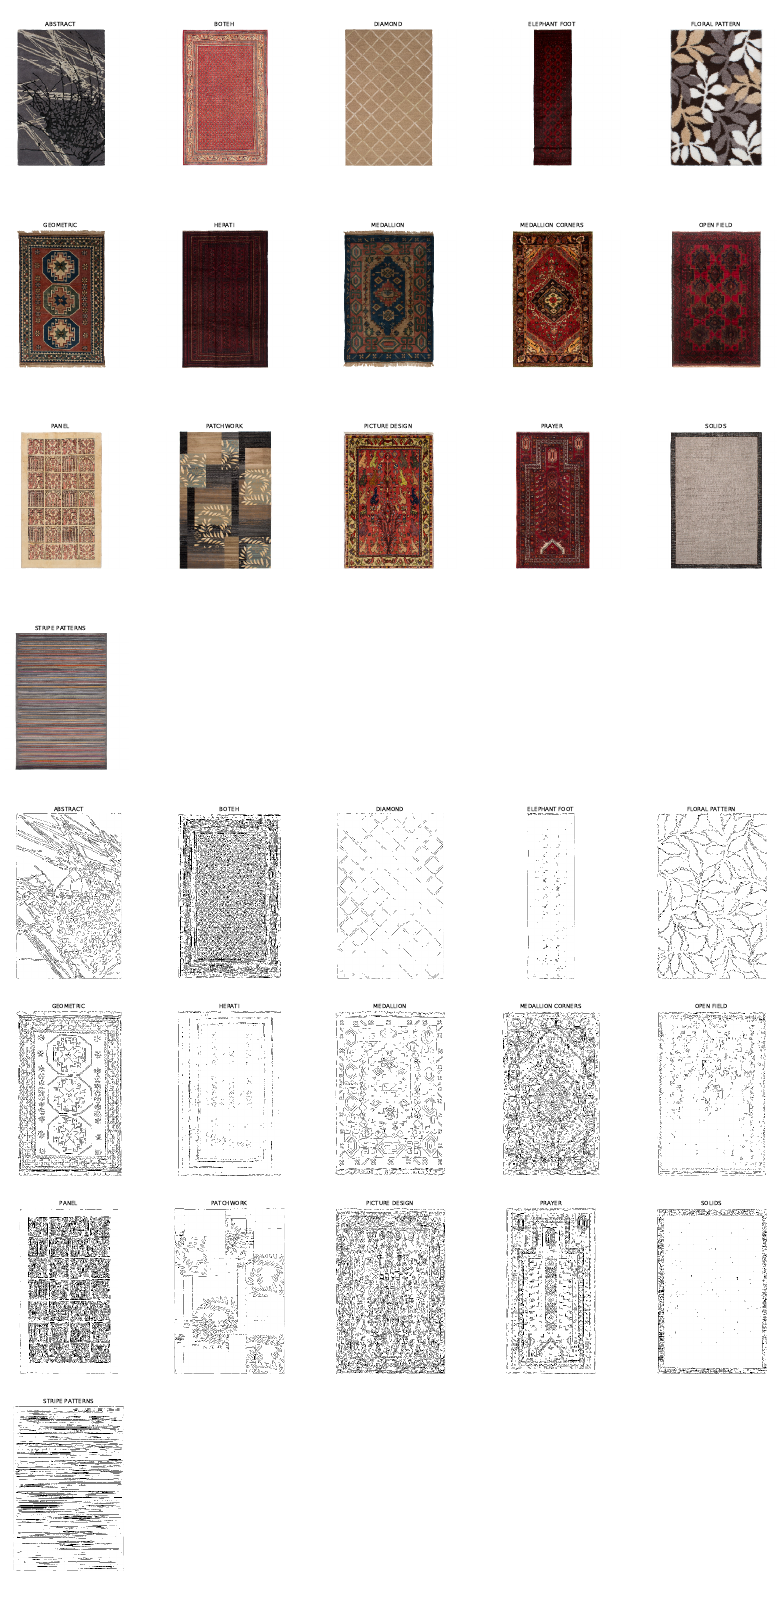
Figure 2. ( Top ): Sample carpet with their pattern levels. ( Bottom ): Corresponding edges of top